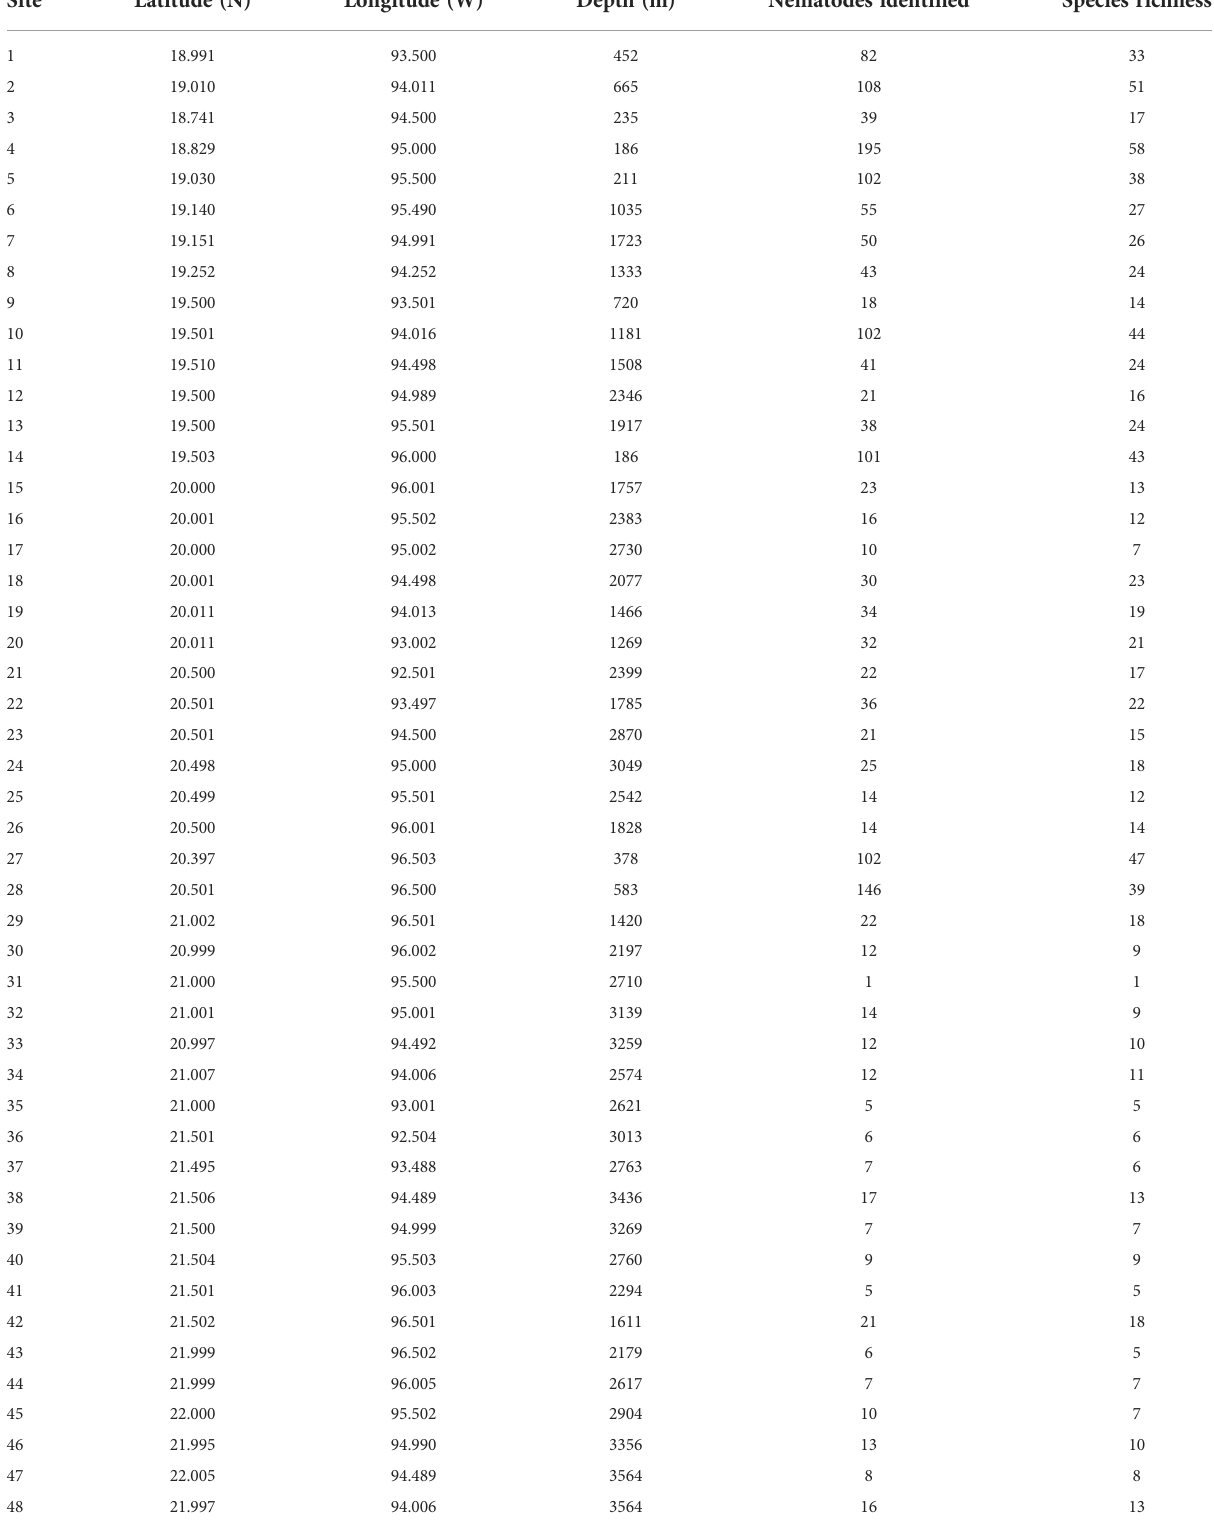
TABLE 1 Sampling sites in the Southwestern Gulf of